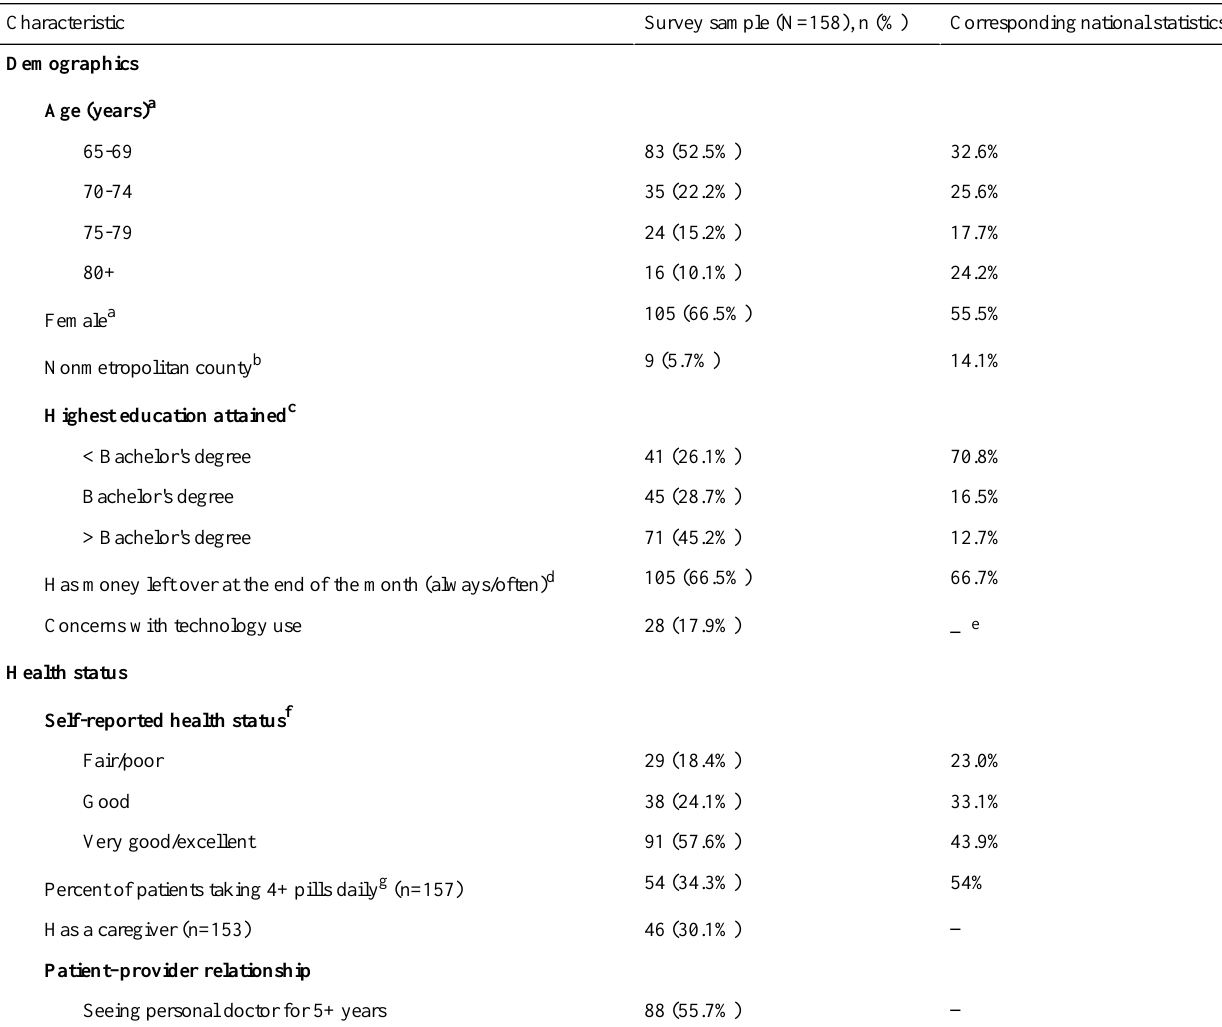
Table 1. Respondents’sample